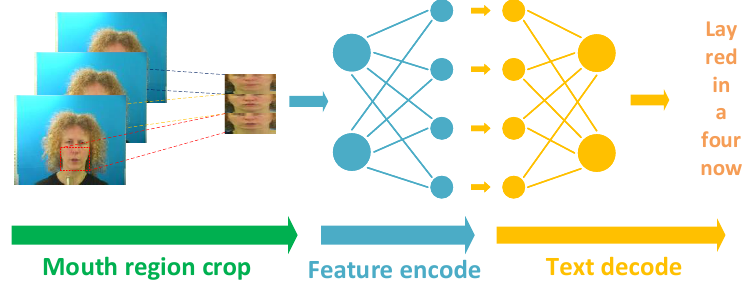
Figure 1. The general end-to-end sentence-level lipreading architecture can be divided into three steps. (1) Cut out the regions of the mouth based on the alignment of the face in each frame of the video; (2) The feature extractor extracts visual features from the input image sequence. (3) A text encoder predicts the text output from the hidden feature